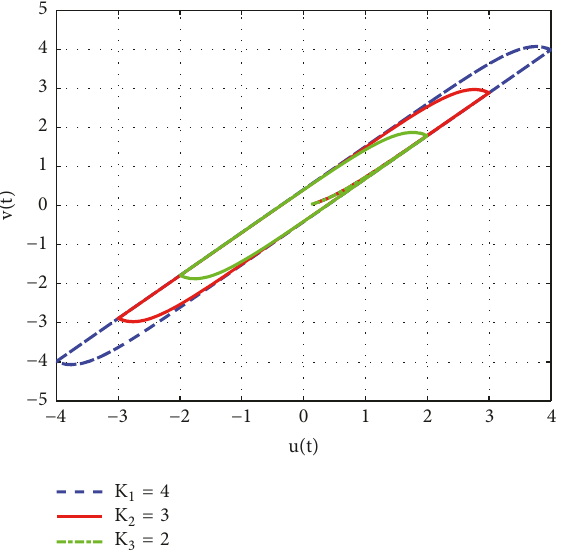
Figure 1: The curves of the backlash-like hysteresis